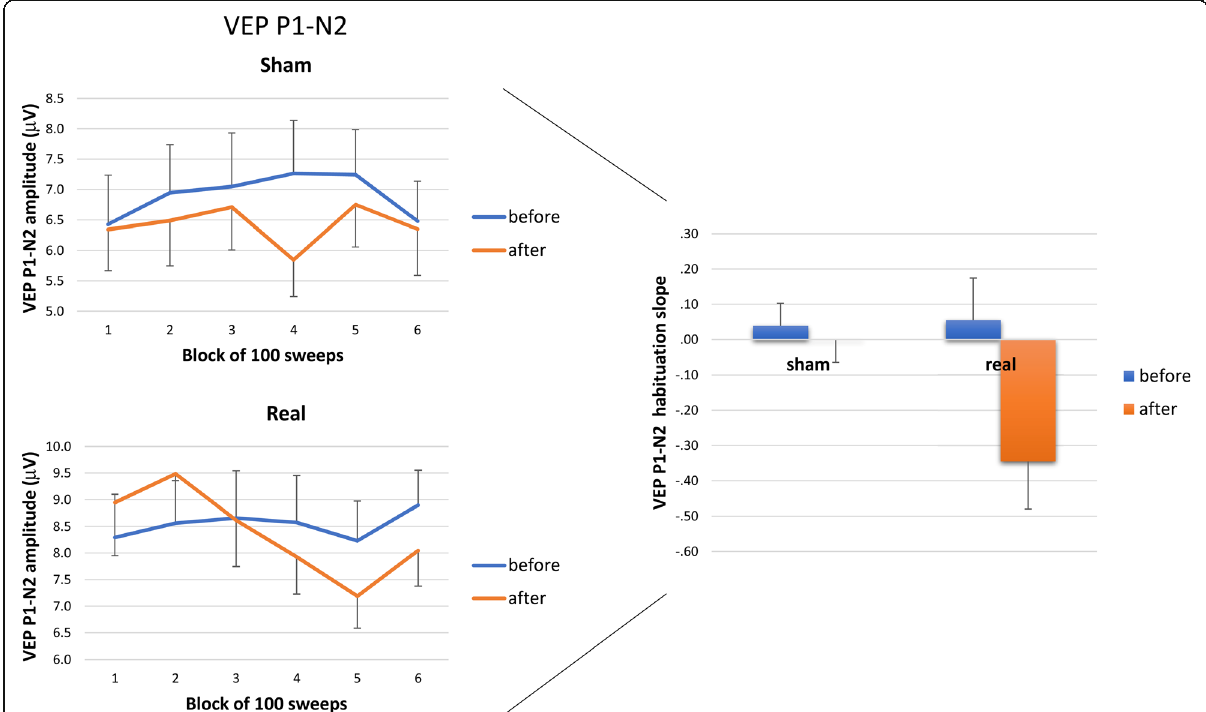
Fig. 2 Left panel: Amplitudes (mean ± standard error of the mean) of the P1 – N2 visual evoked potential (VEP) component in 6 sequential blocks of 100 recordings are shown before and after sham tDCS (upper panel) and real tDCS (lower panel). Right panel: The bar graph represents the habituation slope of VEP P1 – N2 peak-to-peak amplitudes (mean ± standard error of the mean) before and after sham tDCS and real